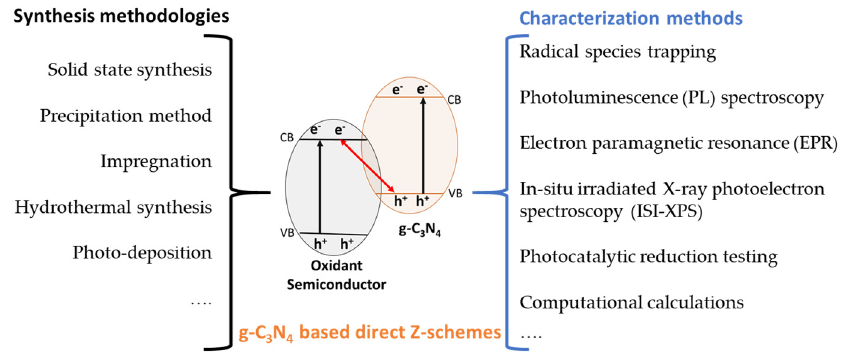
Figure 6. Scheme of representative synthesis and characterization methodologies of g -C 3 N 4 -based direct Z-schemes.